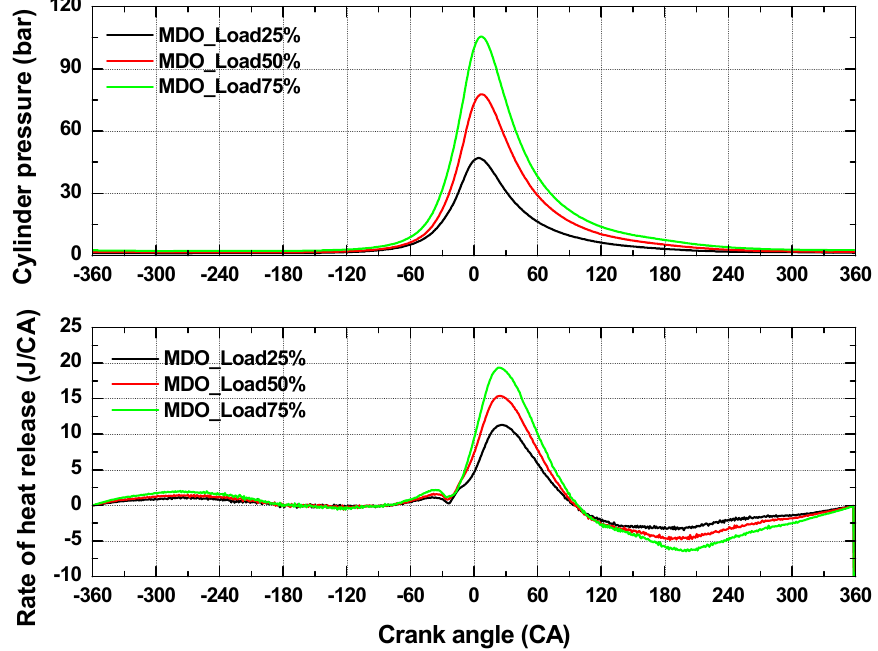
Figure 2. Characteristics of the cylinder pressure and heat release in a conventional marine engine with MDO.